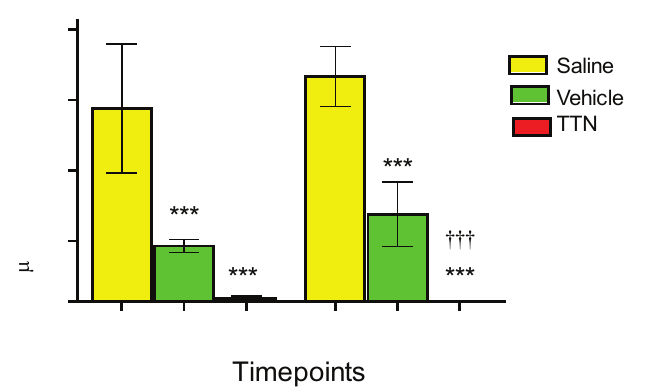
FIGURE1 - Thiobarbituric acid-reactive substances concentrations (micromoles of malondialdehyde per gram of fresh tissue) in the testis of saline, DMSO and ternatin (TTN) pretreated rats. Bars represent mean ± SD of control (yellow bars), vehicle (green bars) and TTN (red bars) groups at the end of the ischemia (T-0) and during reperfusion (T-3). *** P< 0.001, vehicle and TTN groups are significantly different from control group by ANOVA test. ††† P< 0.001, compared with vehicle group.